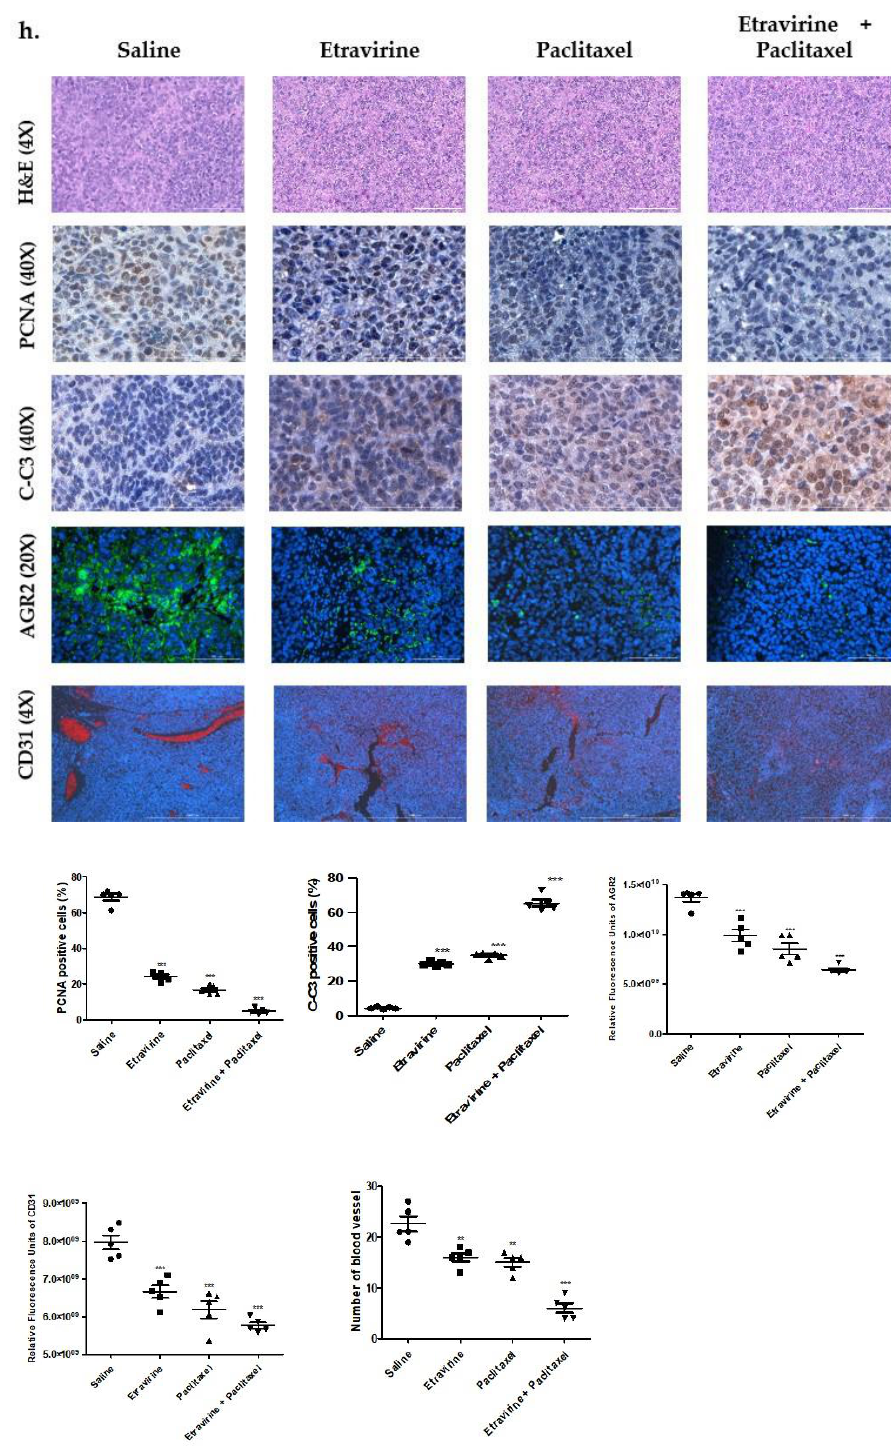
Figure 6. Combination treatment of etravirine and paclitaxel suppressed tumor growth and metas- tasis in the A2780 orthotopic xenograft model. ( a , b ) A2780 cells were injected into the ovarian bursa sac of nude mice (five mice per group). Randomized mice were treated with control (saline), etravirine (100 mg/kg x three times per week by i.p. injections), paclitaxel (15 mg/kg once a week), and a combination group for three weeks. Representative fluorescence images of female nude mice after three weeks of treatment. ( c , d ) Tumor weight and tumor size were measured at the end of the treatment. ( e ) Mice body weights were monitored weekly. ( f , g ) Metastatic tumors were counted and measured. ( h ) Representative H&E staining, IHC images, and quantification of cell proliferation